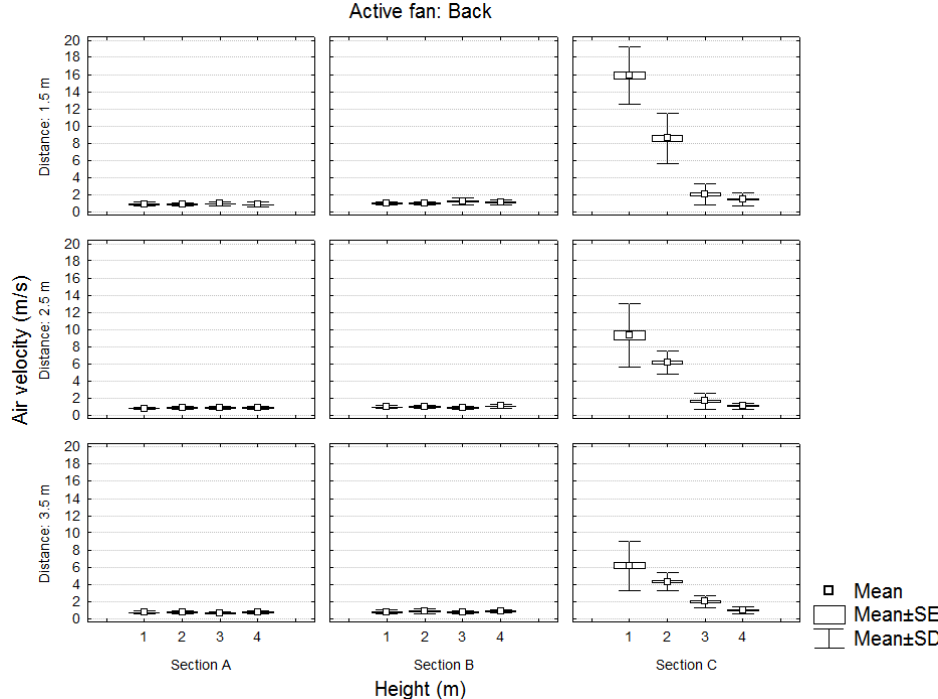
Figure 7. Static test of the sprayer with the back fan powered. Air velocity values for each section in function of the height and distance of the measurement point.